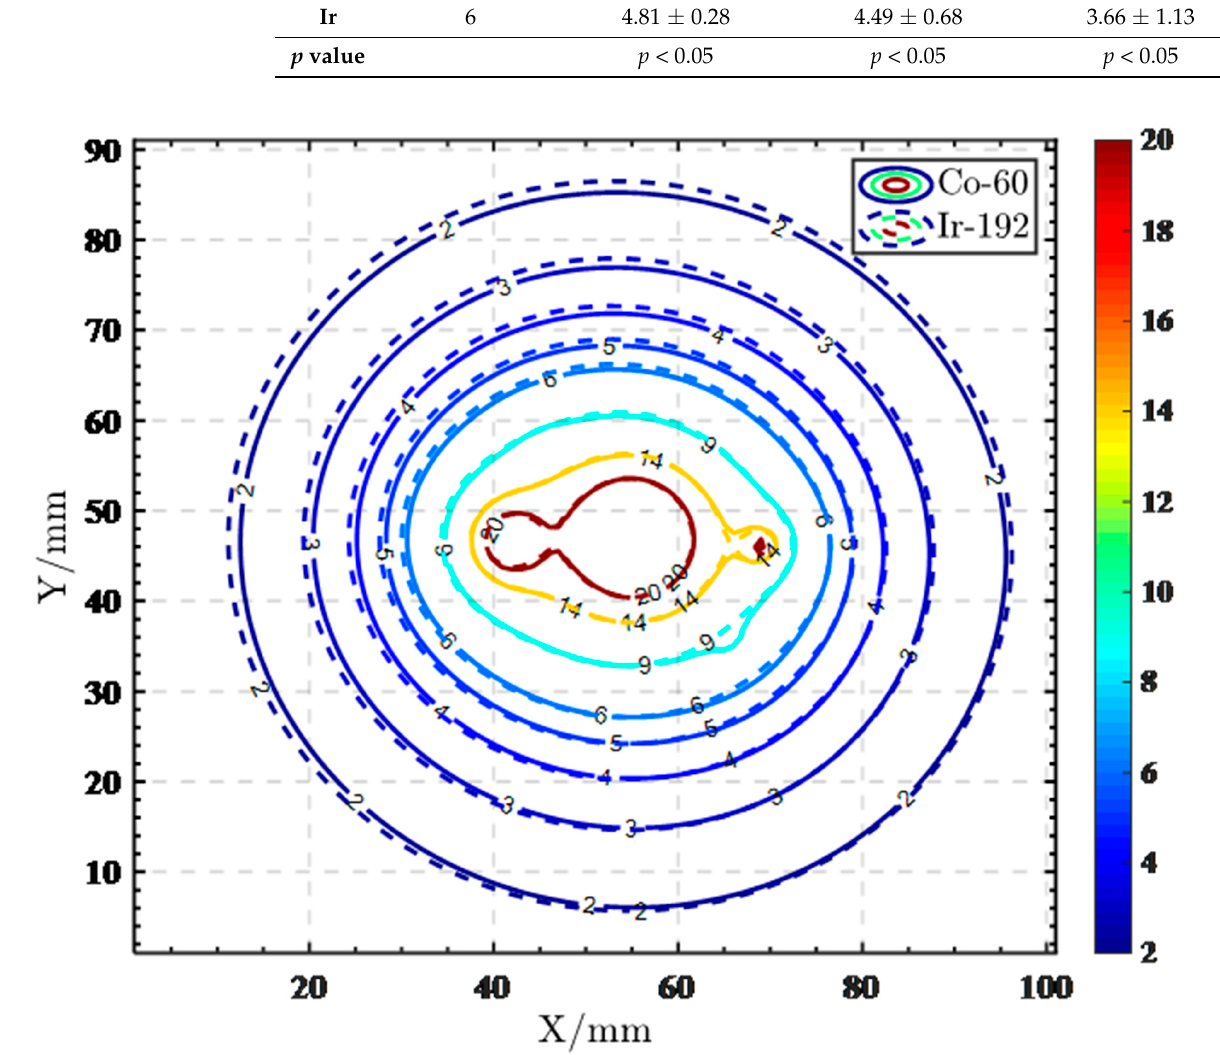
Figure 8. (3D HDR IC-ISBT) Cross-sectional isodose line distribution of 192Ir and 60Co.